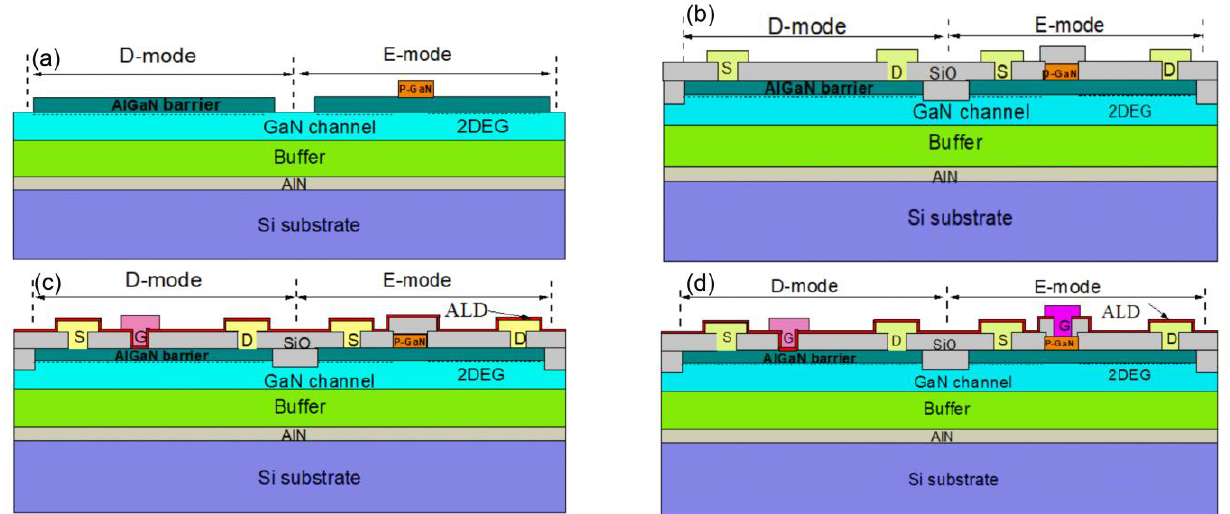
Figure 2. Schematic cross-section of ( a ) after p-GaN etching, ( b ) after source and drain formation and ( c ) after gate metal etching of the D-mode GaN high-electron-mobility transistor (HEMT) device and ( d ) after the gate metal etching of the E-mode GaN HEMT device.